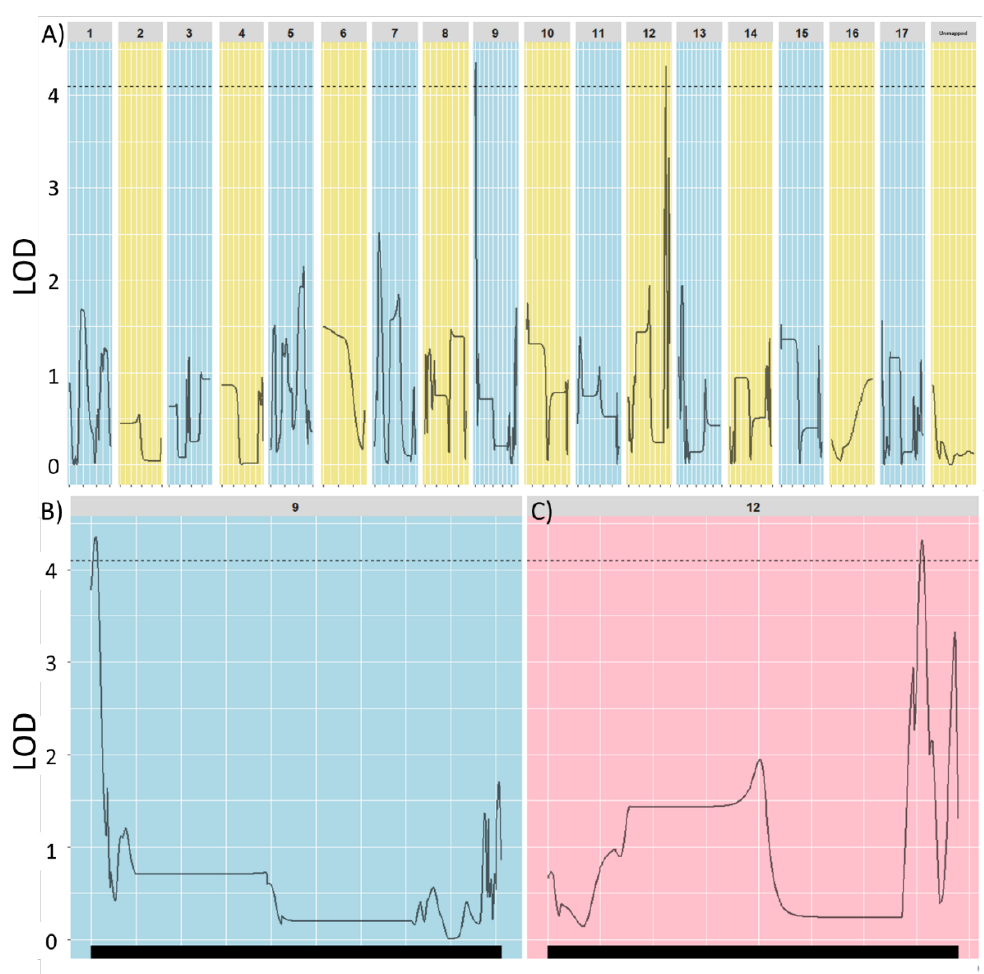
Figure 3. Quantitative trait locus (QTL) for tuber formation identified after markers placed on the HA412-HO genome, ( A ) Haley-Knott regression identified two significant QTL, implying oligogenic control across the seventeen chromosomes of Helianthus annuus ; ( B ) Chromosome 9 close up and corresponding QTL; ( C ) Chromosome 12 close up and corresponding QTL. In all panels, the dotted line indicates a significance level of p < 0.01 as determined by a permutation test. LOD (logarithm of the odds).